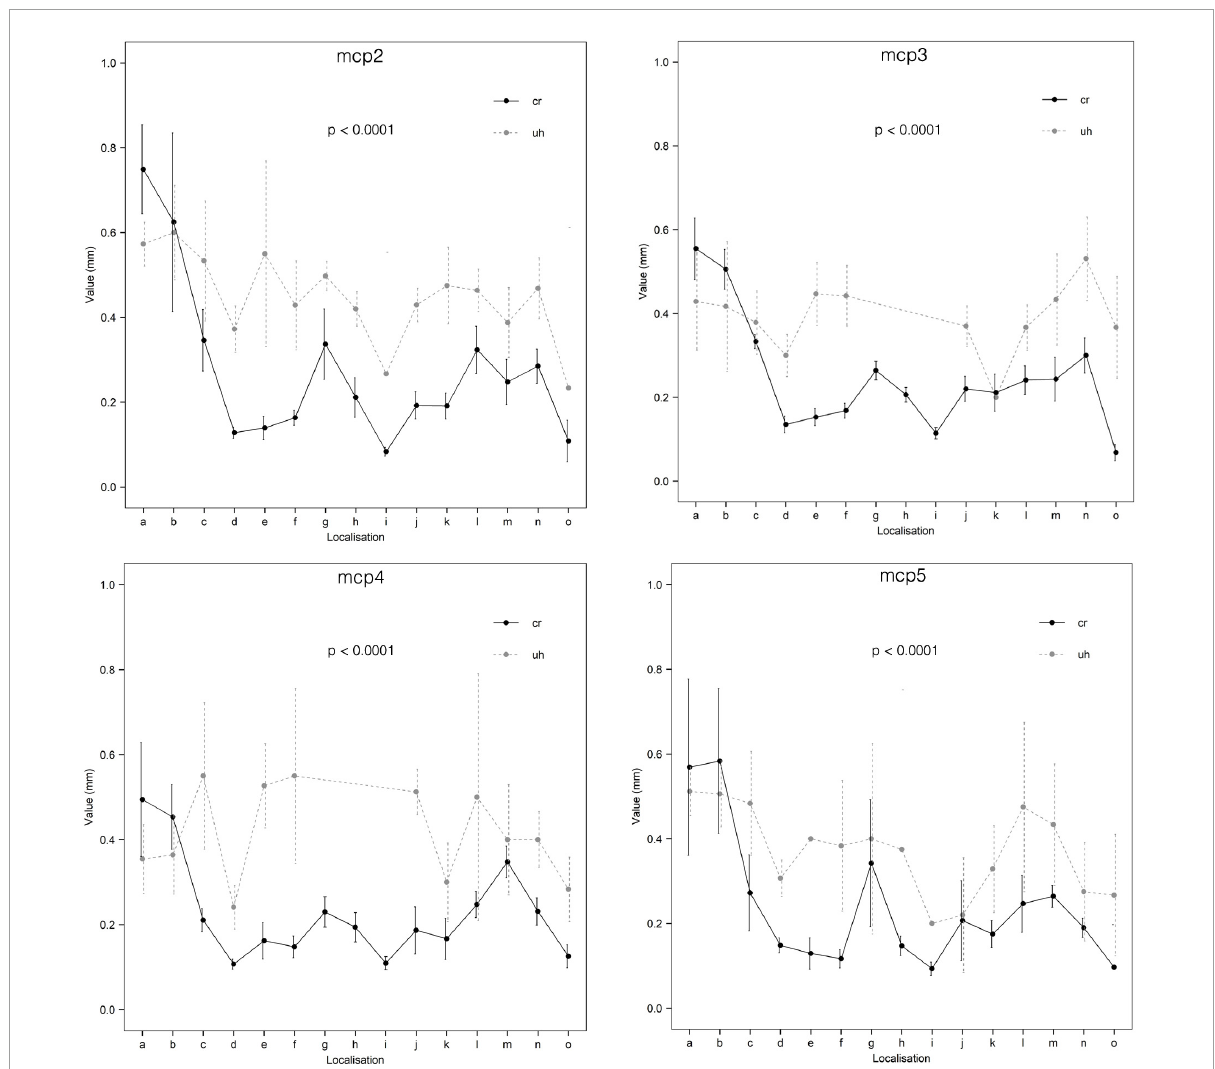
FIGURE8 Comparison of ultrasonographic and cryosectioned diameter measurements (CI = 95%). cr, cryosectioning; uh, ultrasonography; a, R-branch; b, U-branch; c, dorsal arcade; d, dorsal enosseal; e, palmar enosseal; f, dorsal triangle arcade; g, main lateral artery; h, enthesial; i, enosseal lateral; j, palmar plate radial; k, palmar plate ulnar; l, tenosynovial branch radial; m, tenosynovial branch ulnar; n, phalanx arcade; o, phalanx dorsal